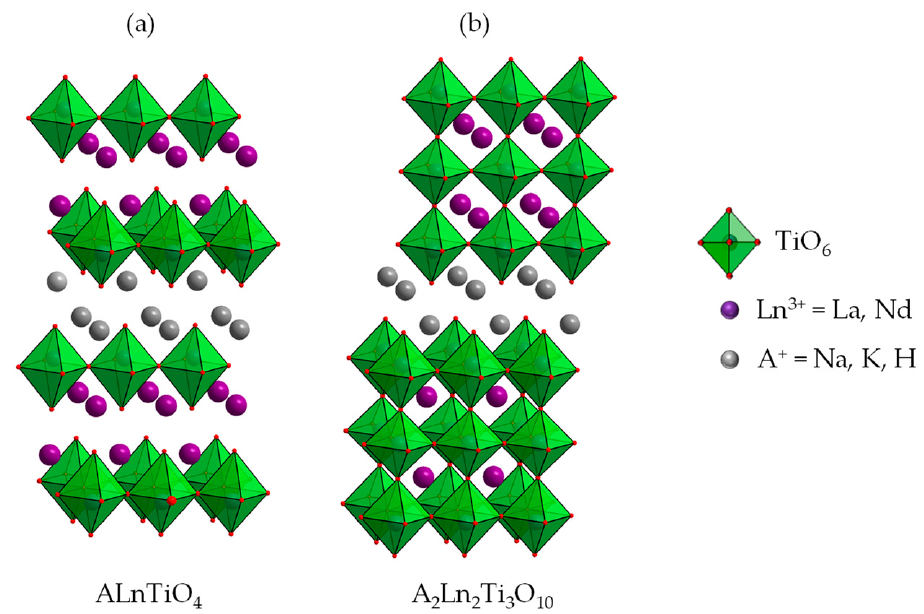
Figure 1. Structure of ALnTiO 4 ( n = 1) ( a ) and A 2 Ln 2 Ti 3 O 10 ( n = 3) ( b ) titanates.